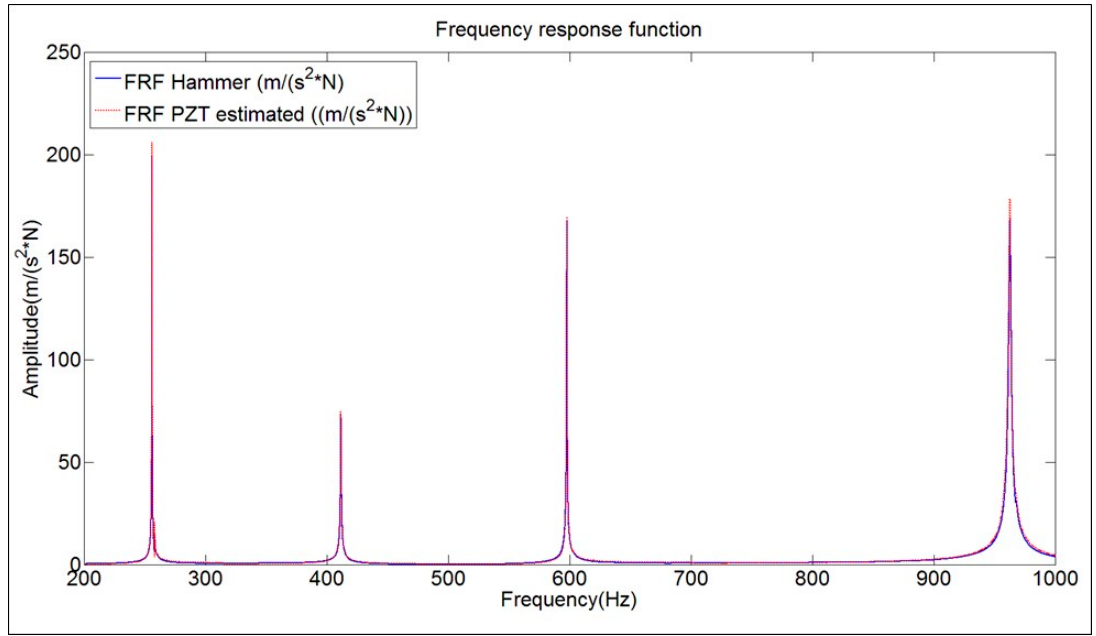
Figure 13. Comparison FRF obtained with Hammer and FRF estimated with the PZT combined with the proposed method. Structure suspended in air. the proposed method. Structure suspended in